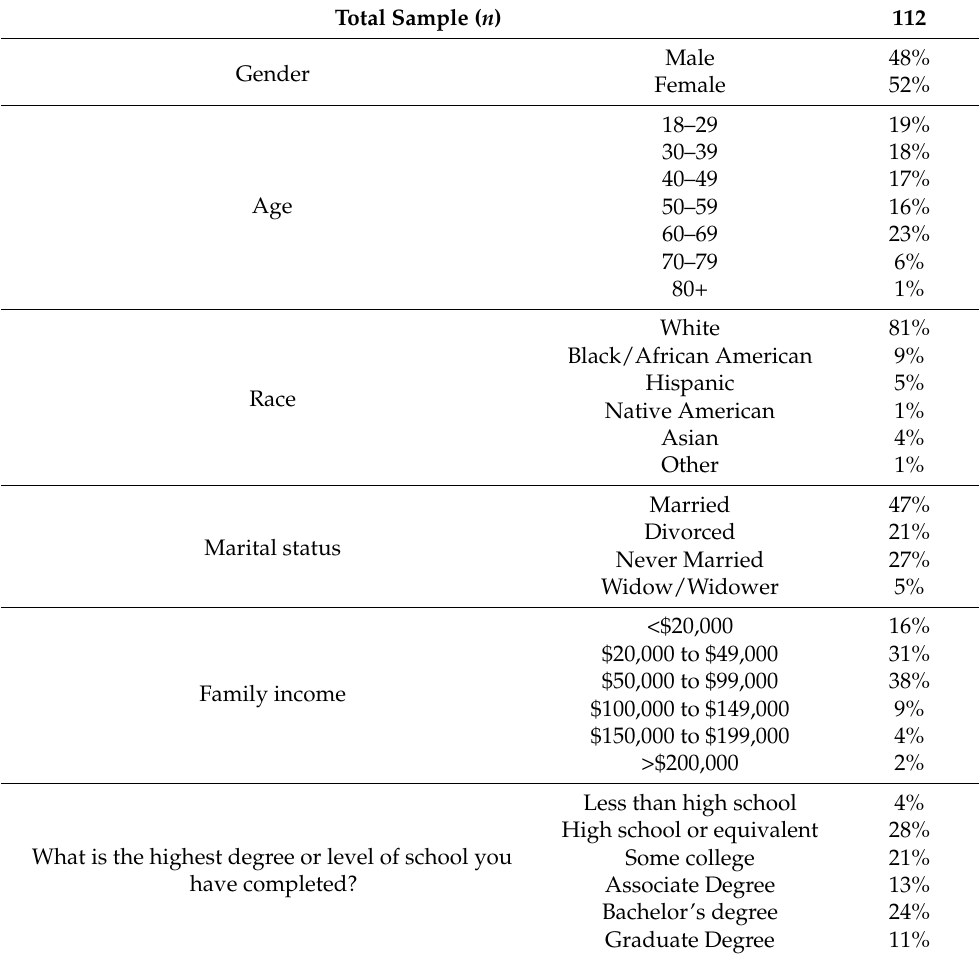
Table 1. Demographics of the Sample. Total Sample ( n )